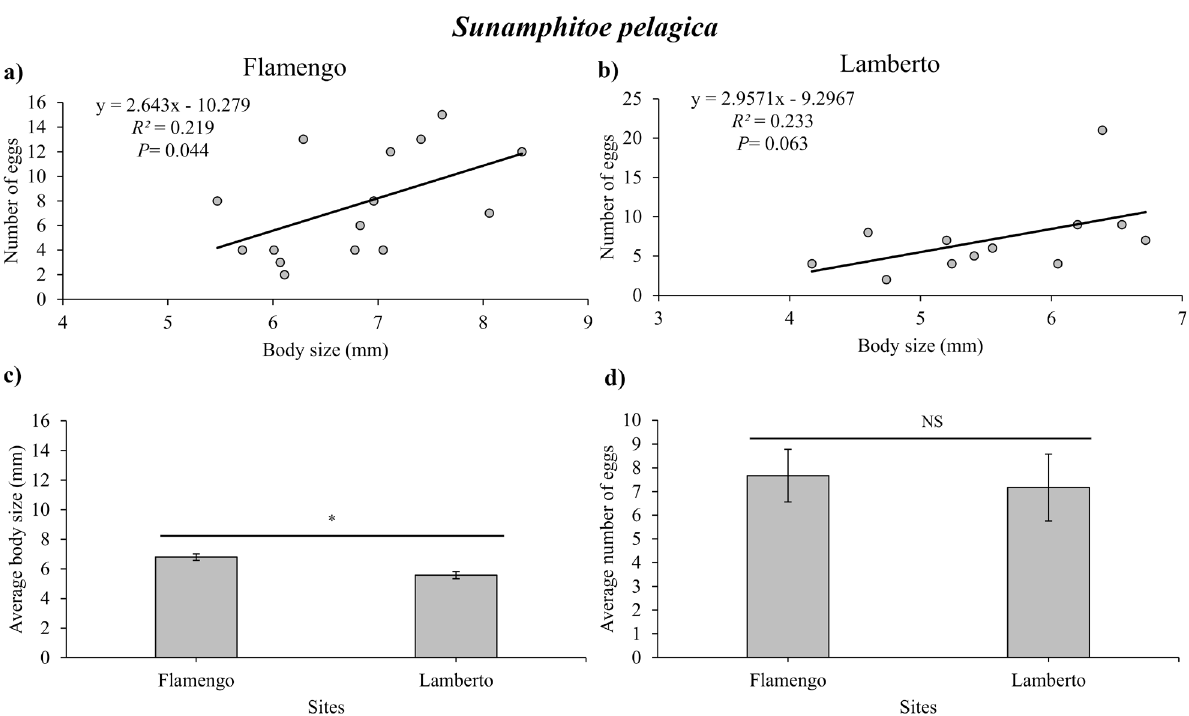
Figure 4. Linear regression between average body size and number of eggs of Sunamphitoe pelagica species at two locations, ( a ) Flamengo and ( b ) Lamberto; ( c ) Female body size (mm) at two locations and ( d ) Fecundity of S. pelagica at two locations, Flamengo and Lamberto (± standard error). NS represents no significant difference.